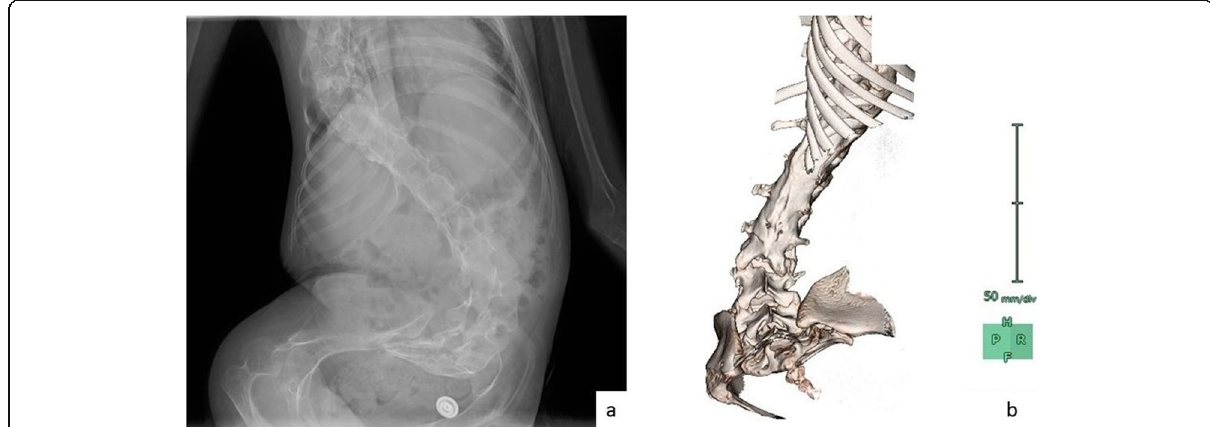
Fig. 1 a A plain anteroposterior X-ray image of the vertebrae. b A three-dimensional reconstructed image of CT scan. A view from the back shows rotation of the vertebrae and fused posterior segment